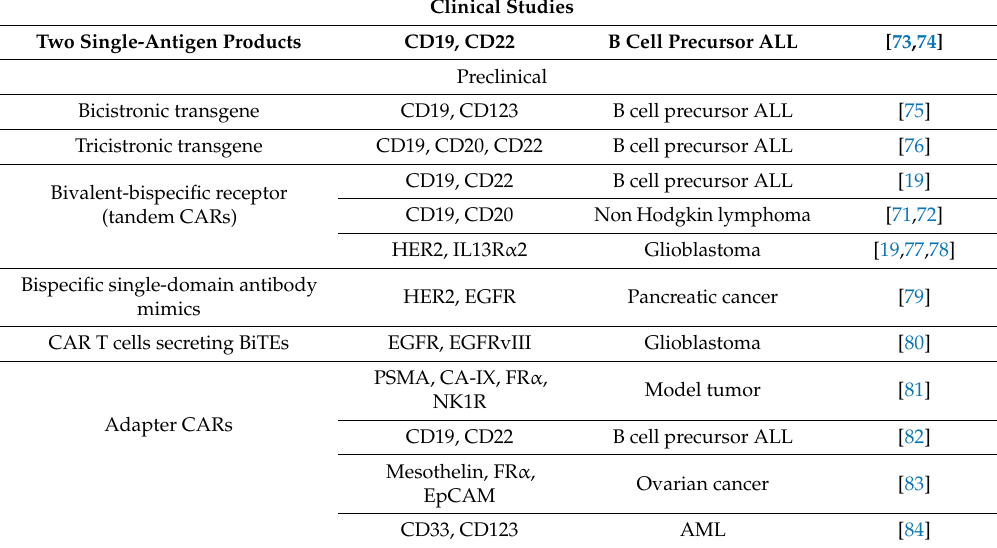
Table 2. Combinatorial targeting